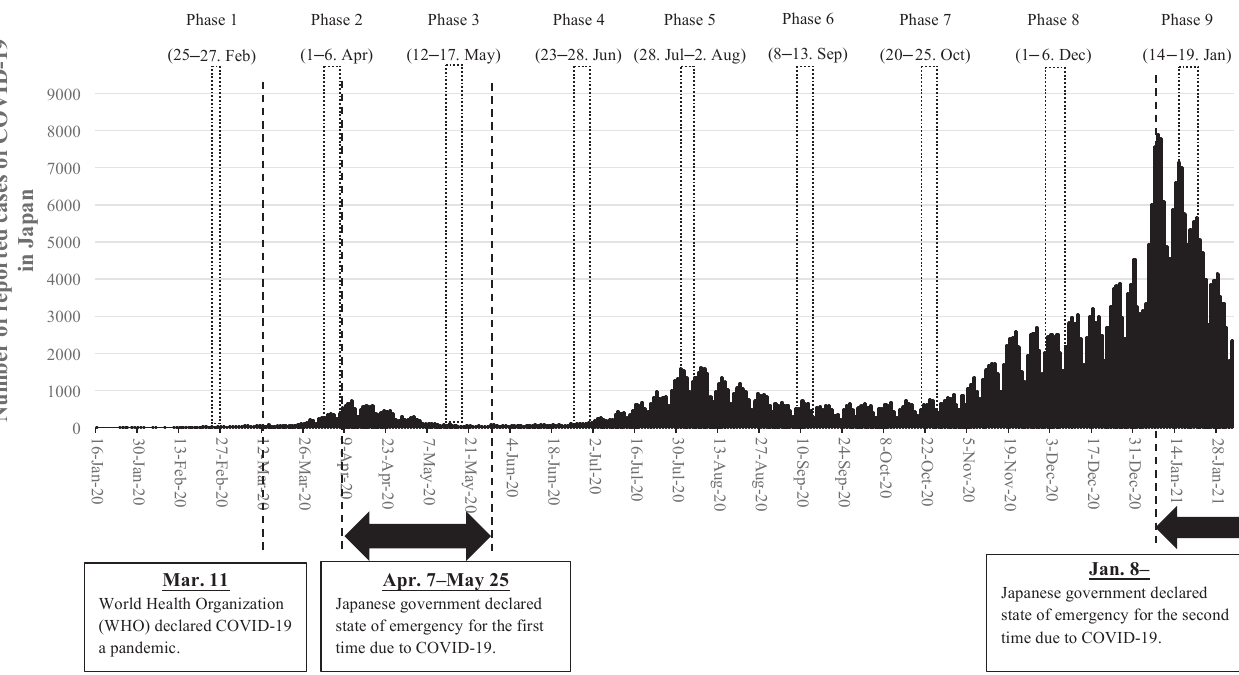
Figure 1. Date of surveys with COVID-19 epidemic curve in